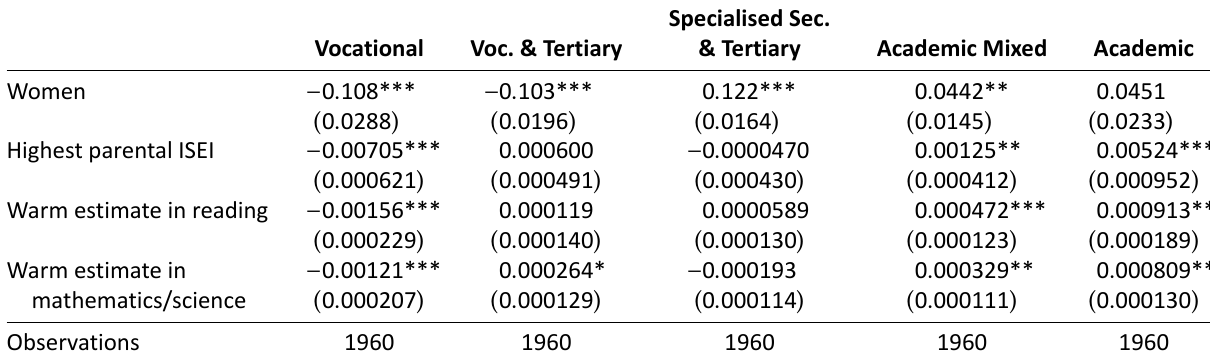
Table 4. Probability of belonging to a certain educational cluster (average marginal effects based on multinomial logistic regression). Source: PISA (2000) and TREE waves 1–9 (weighted; 2016).